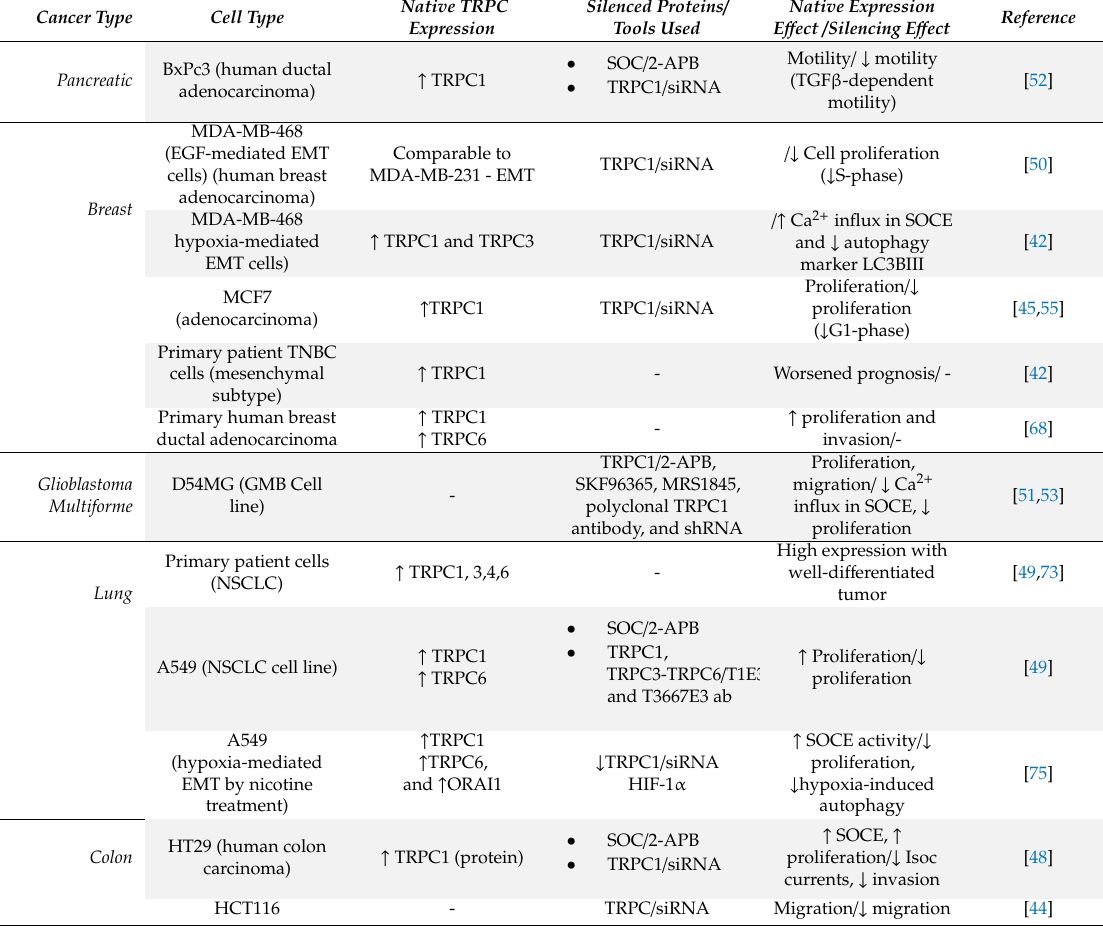
Table 1. Role of TRPC expression or activity in augmenting proliferation and metastasis in cancer. Cancer